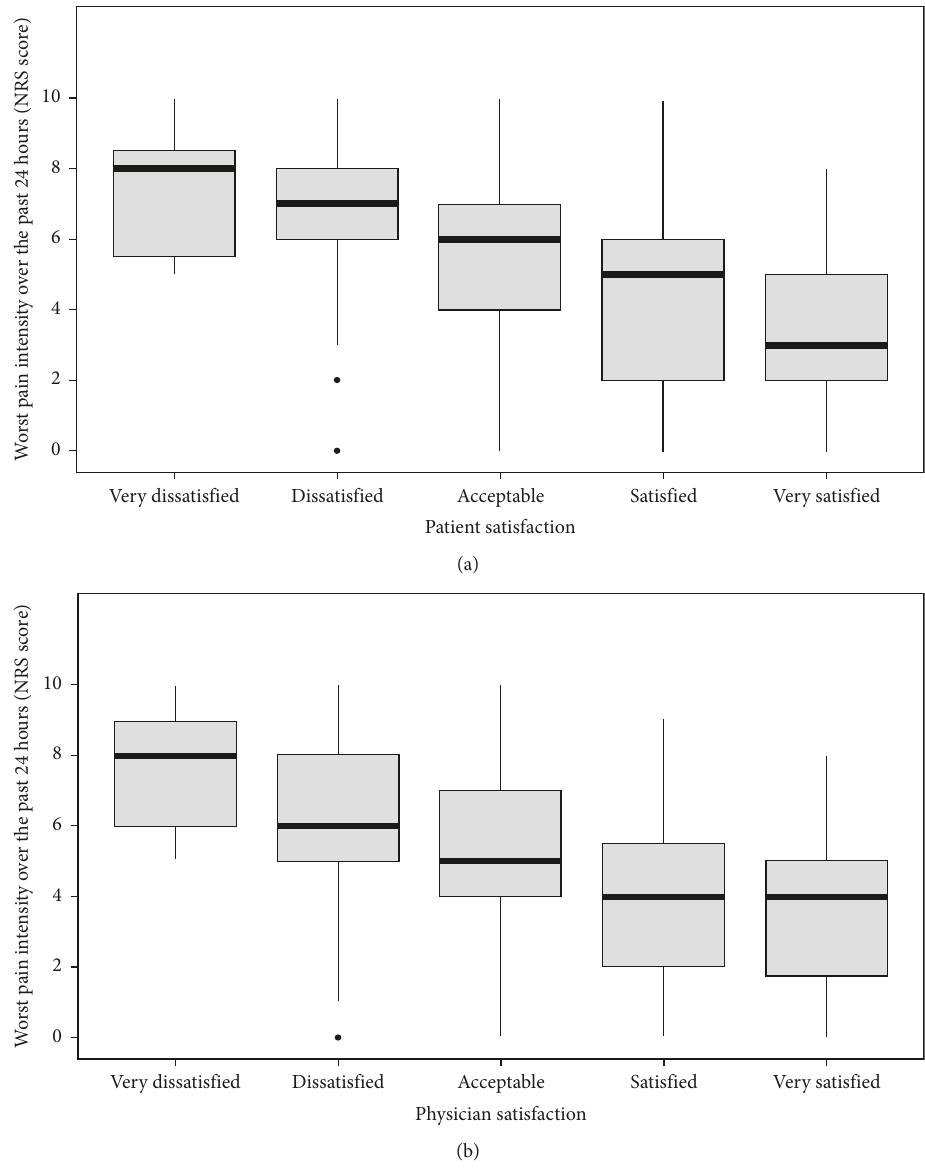
Figure 1: Box plots showing patients’ worst pain intensity over the past 24 hours and (a) patients’ and (b) physicians’ satisfaction with patients’ pain control. Horizontal line within the box plot indicates the median; boundaries of the box represent the 25th- and 75th- percentile; filled symbols denote